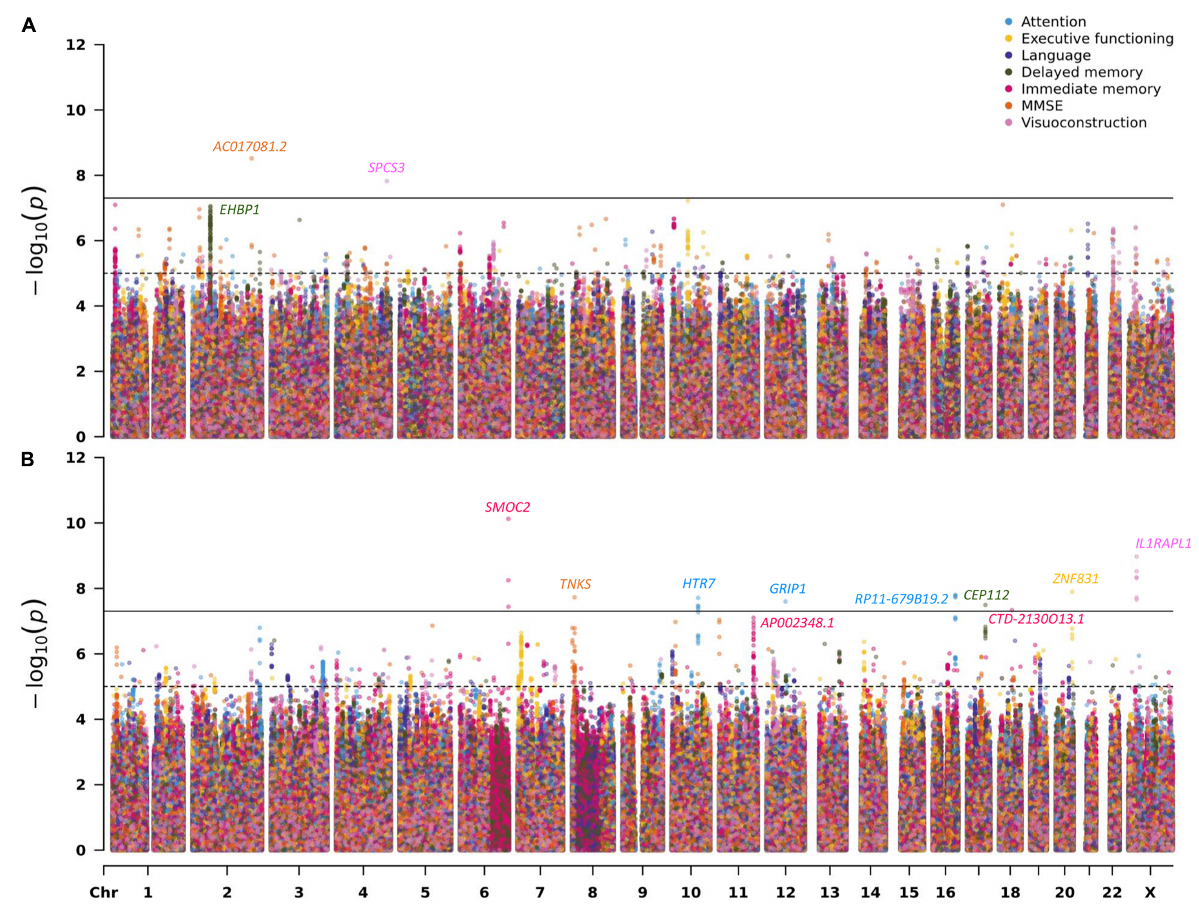
Frontiers in Aging Neuroscience |